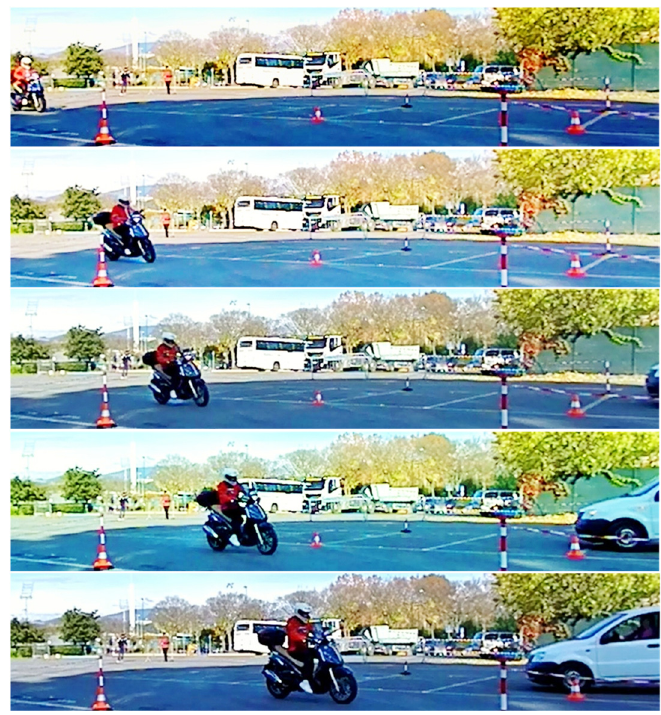
Figure 2. Example of a loss of control case after locking the front wheel.